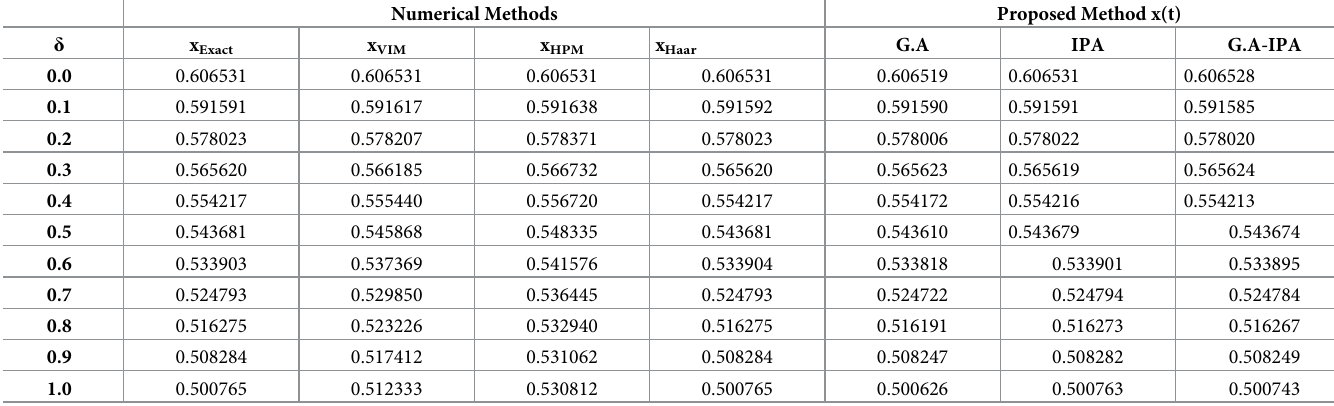
Table 10. Approximate solutions by numerical methods and proposed method for different δ and t =